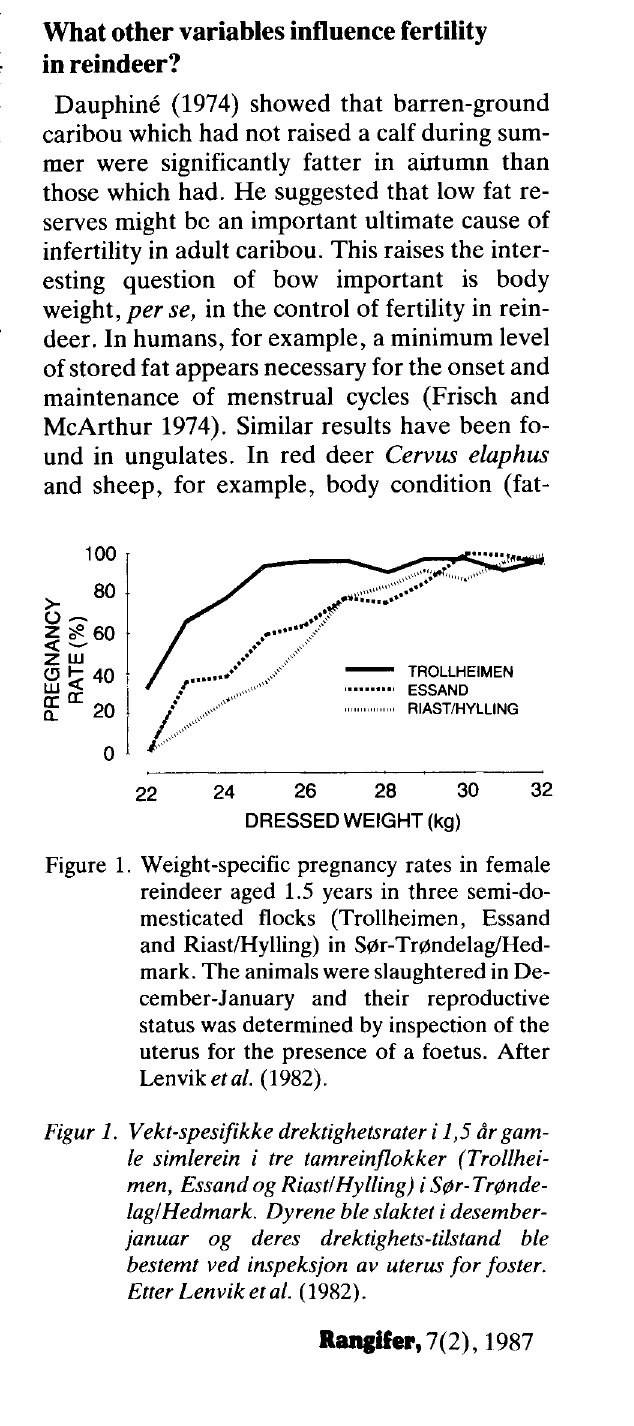
Figure 1. Weight-specific pregnancy rates in female reindeer aged 1.5 years in three semi-do mesticated flocks (Trollheimen, Essand and Riast/Hylling) in Sør-Trøndelag/Hed- mark. The animals were slaughtered in De cember-January and their reproductive status was determined by inspection of the uterus for the presence of a foetus. After Lenvik et al. (1982). Figur 1. Vekt-spesifikke drektighetsrater i 1,5 år gam le simler ein i tre tamrein/lokker (Trollhei men, Essand og Riast/Hylling) i Sør-Trønde- lagl Hedmark. Dyrene ble slaktet i desember- januar og deres drektighets-tilstand ble bestemt ved inspeksjon av uterus for foster. Etter Lenvik et al.